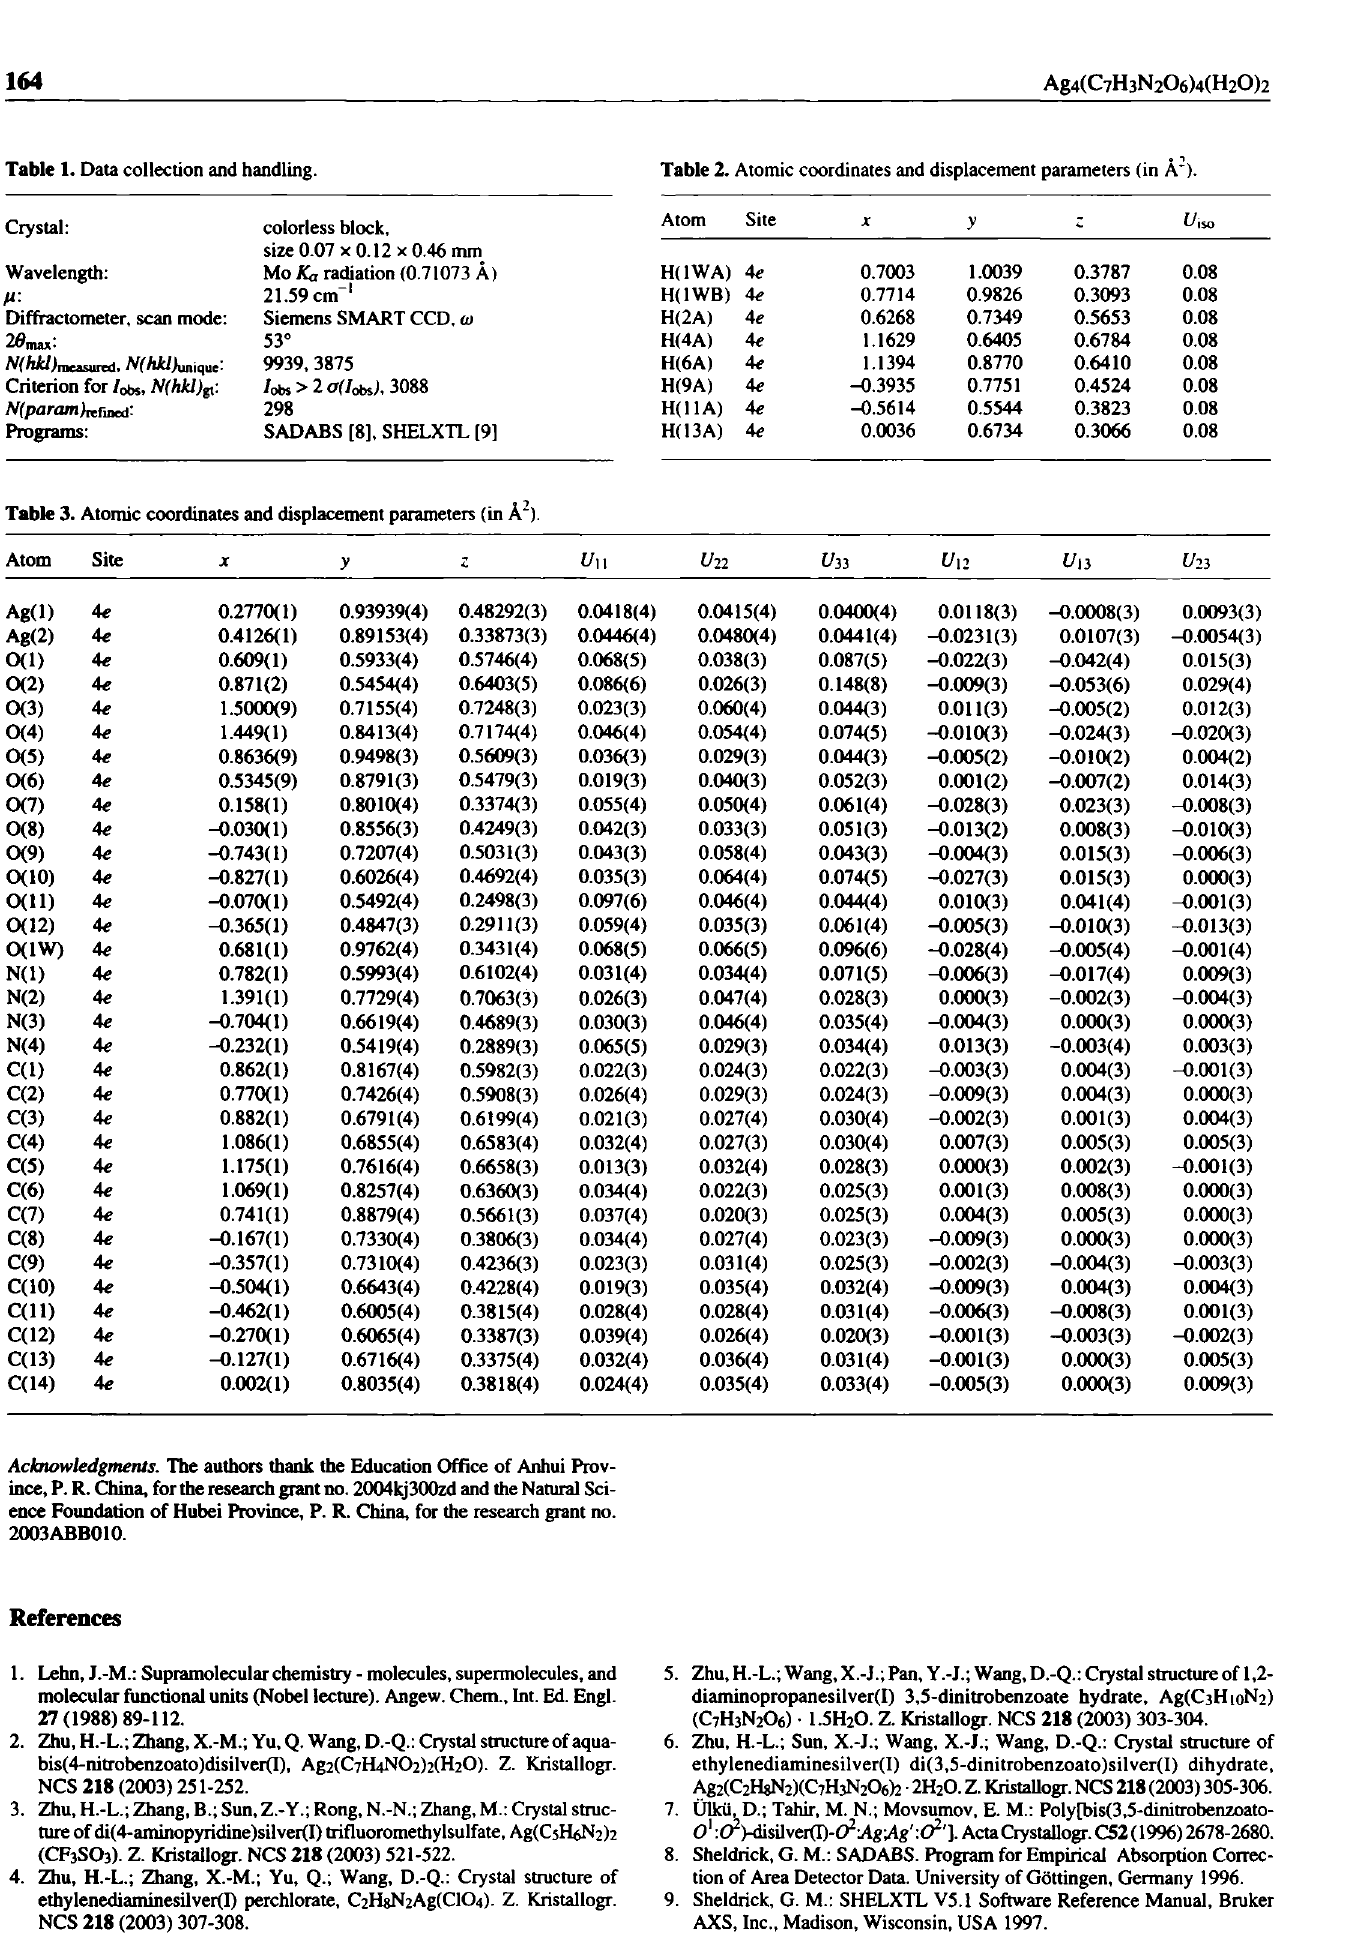
Table 3. Atomic coordinates and displacement parameters (in À 2